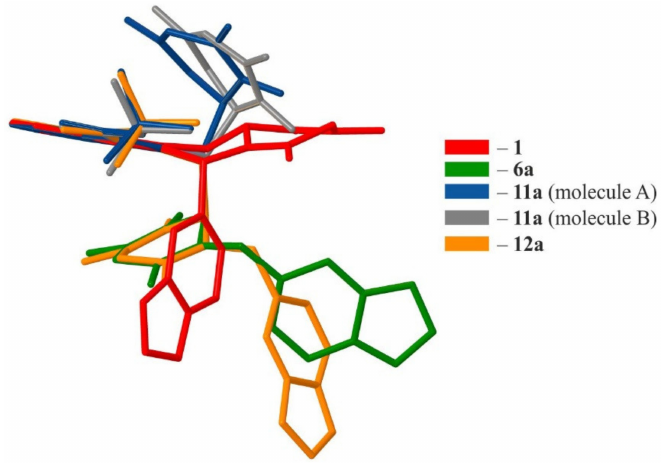
Figure 9. Superimposed molecules of 1 , 6a , 11a and 12a . The H-atoms were omitted for clarity.